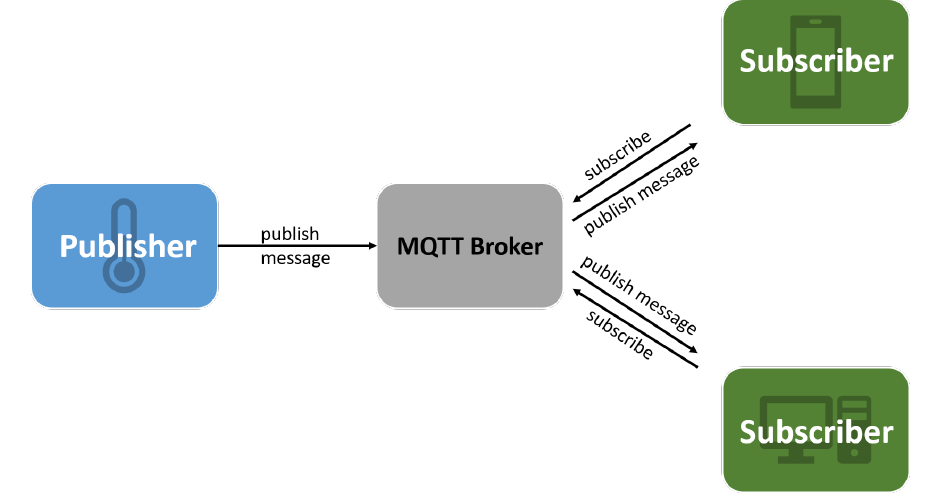
Figure 1. MQTT general components schema and